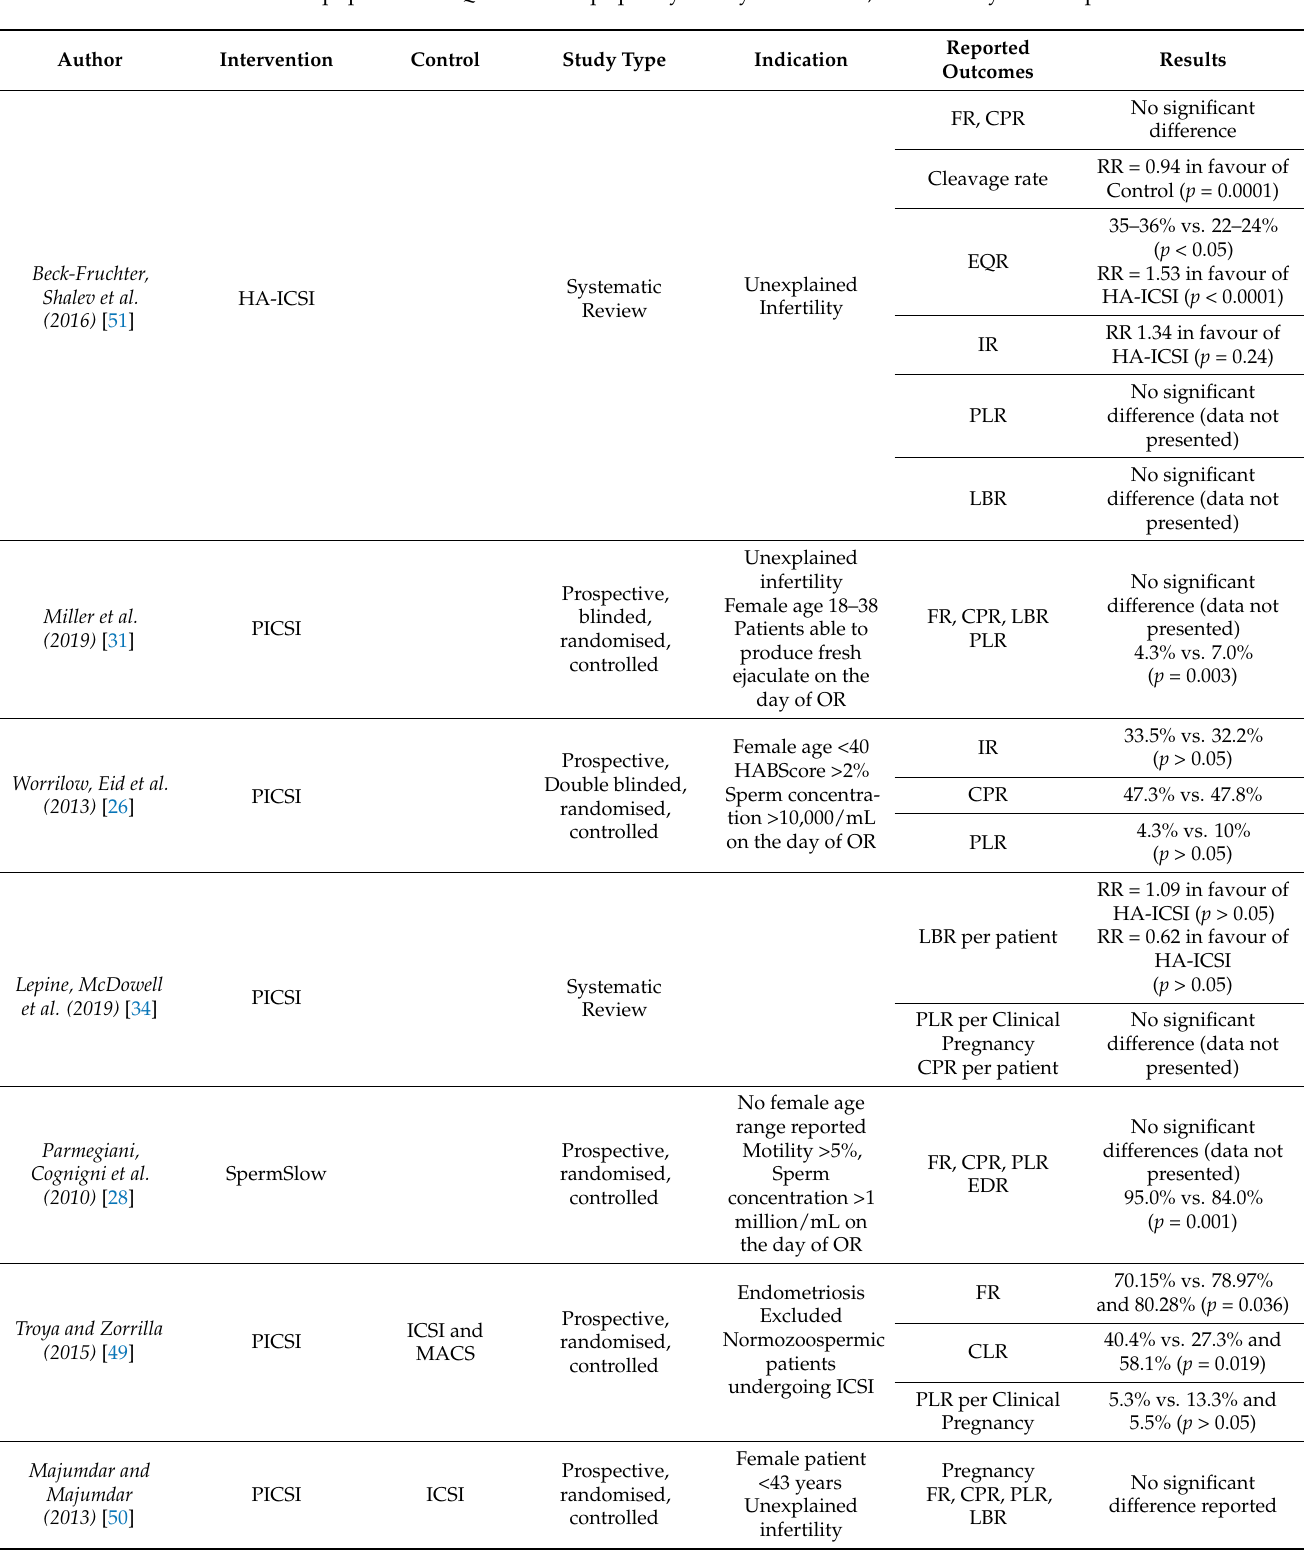
Table 3. A table summarising the studies included in this review for study question 3, involving the assessment of the effect of HAB-sperm selection on clinical outcomes in the unexplained fertility population. EQR: rate of top-quality embryo formation; EDR: embryo development